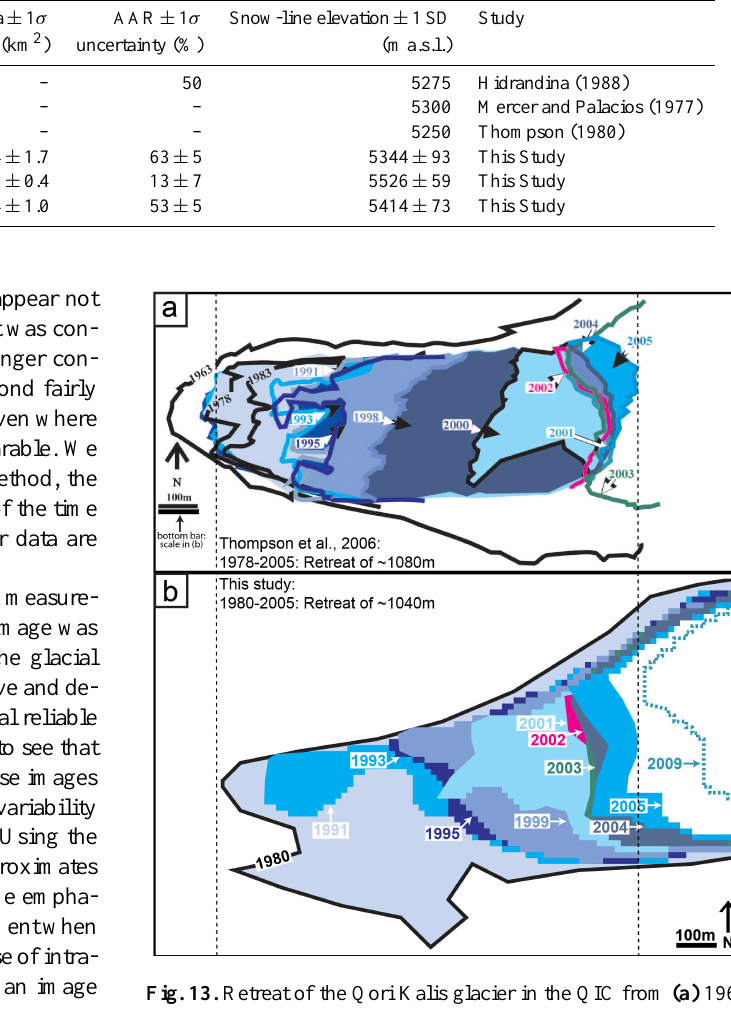
Fig. 13. Retreat of the Qori Kalis glacier in the QIC from (a) 1963 to 2005 (figure modified after Thompson et al., 2006) and (b) 1980 to 2009 (results from this study). This comparison shows field- based measurements (a) and our satellite-based measurements (b) . Dashed lines are used for ease of viewing beginning and ending glacier extents in ∼ 1978 and